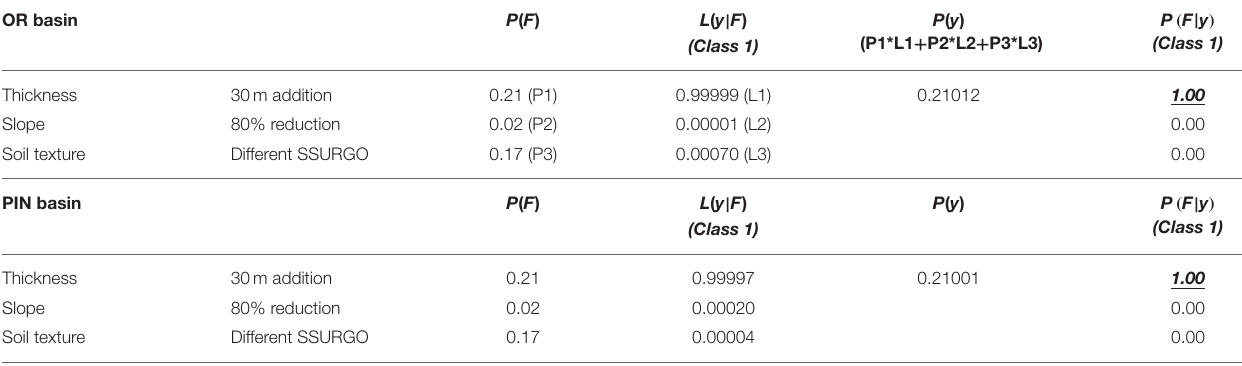
TABLE 2 | Calculations of the data-centric Bayesian inference framework for three factors. OR